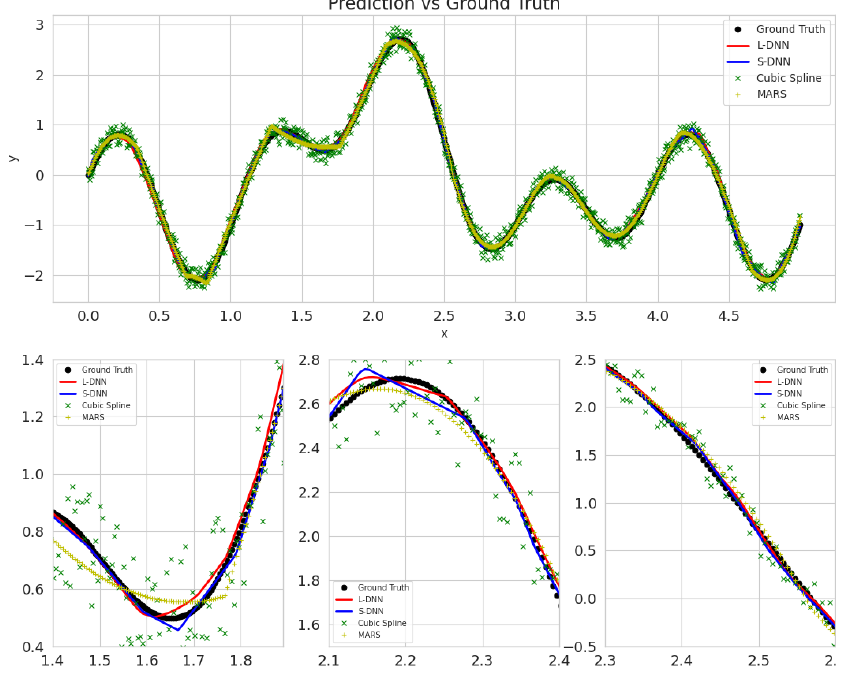
Figure A4. Predictions’ of all tested methods on the test set for noise = 10%, trained on 900 samples. Blue represents SDNN, red LDNN, green cubic splines, and yellow